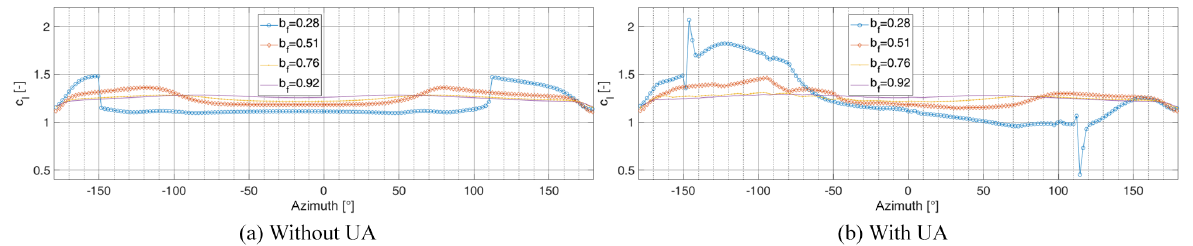
Figure 5. (a) c l vs. ψ for various blade stations ( b f ) and for γ = 10 ◦ offset as calculated by AD15 for a hub-height wind speed of 12ms − 1 . (b) As in (a) but with UA effects included. as calculated by AD15 (without induction) for various blade stations ( b f ) and hub-height wind speeds Table 2. Ranges ( (cid:49) ) for α , c l , and U 2 rel ( U hub ) and for yaw offsets ( γ ) of 0, − 10, and 10 ◦ . A wind shear exponent of 0.2 was assumed. The calculated reduced frequencies ( k ) for the various airfoil stations are also given. U hub